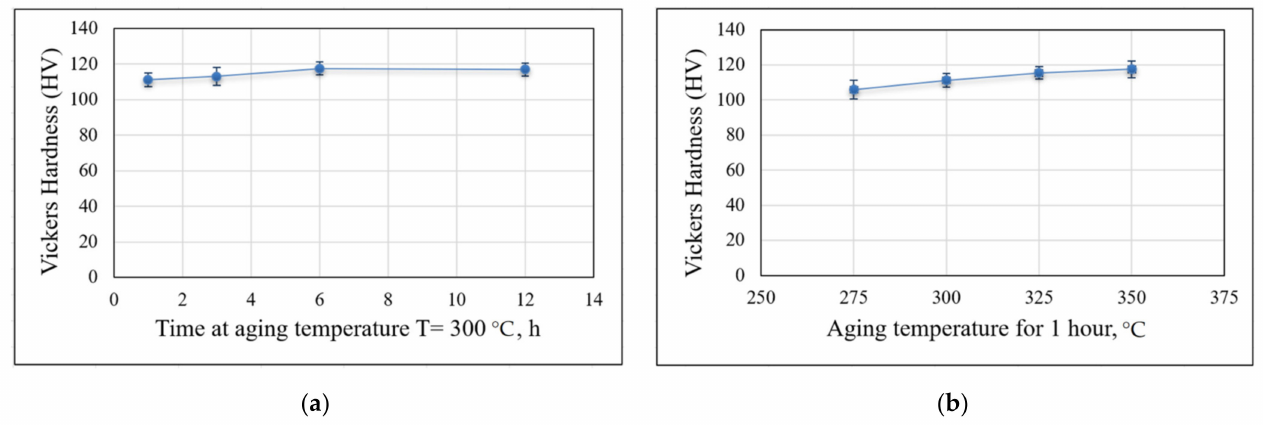
Figure 11. Average values of hardness at various heat treatments: ( a ) at various aging times and a constant temperature of 300 ◦ C; ( b ) at various aging temperatures for 1 hour.